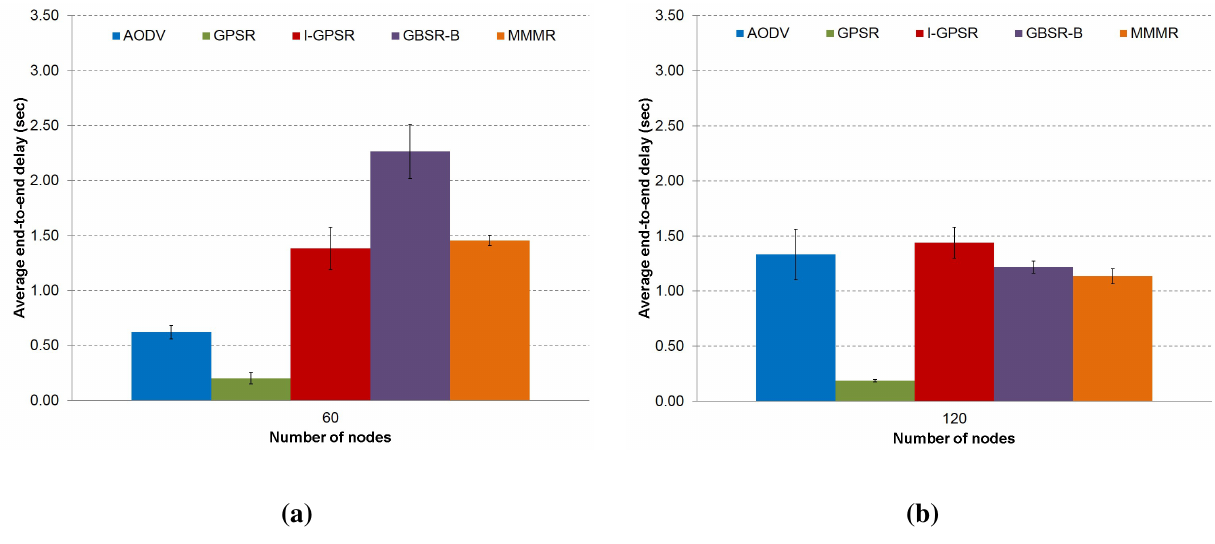
Figure 5. The average end-to-end packet delay in ( a ) a low density scenario (60 nodes) and ( b ) a medium density scenario (120 nodes) are presented, comparing the protocols, AODV, GPSR, I-GPSR, GBSR-B and MMMR (CI